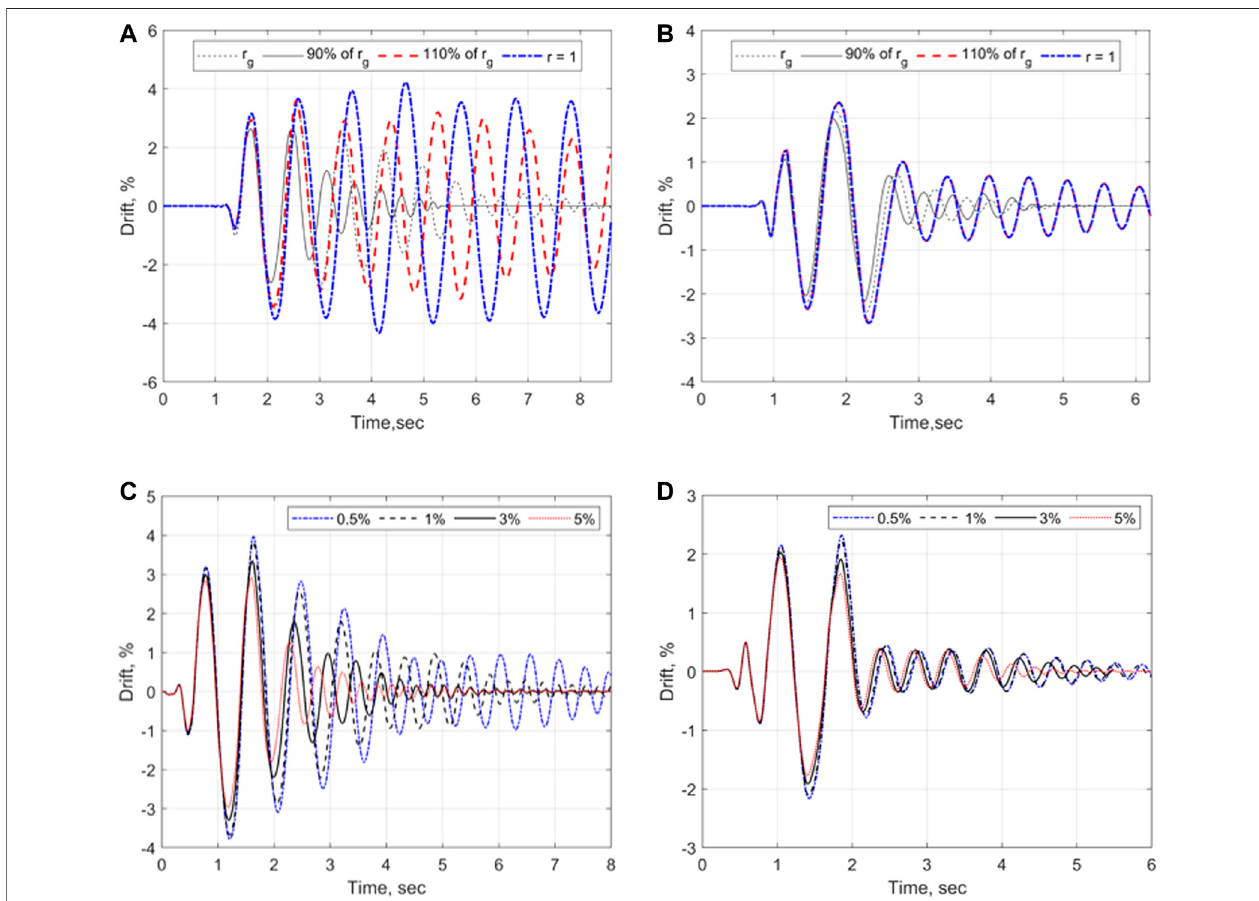
FIGURE 12 | Lateraldrift timehistories by theGDAAand FEM, respectively for variousvaluesof r and ζ impact , during Sylmar: (A) GDAA-SRW2; (B) GDAA-PreWEC-2; (C) FEM-SRW2; (D) FEM-PreWEC-2.